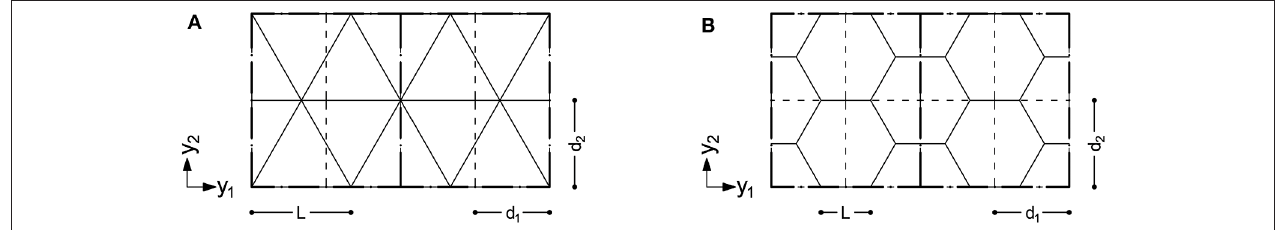
FIGURE 3 | Layout of the (A) diagrids and (B) hexagrids investigated in the numerical simulations: continuous lines stand for bars in the grid; dash lines stand for elements; dash-dot lines stand for a typical patch of 2 2 elements sharing the same cross-section. ×